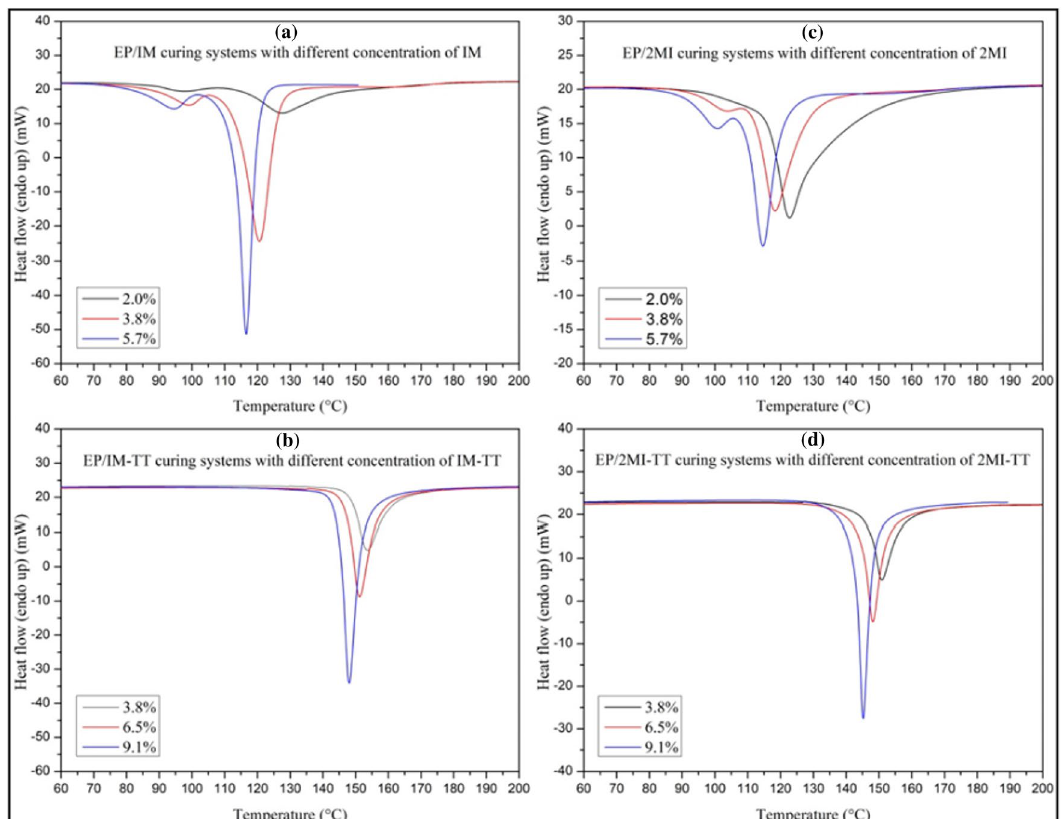
Fig. 4 DSC curves of the EP blends with different ratio of IM, 2MI, IM-TT and